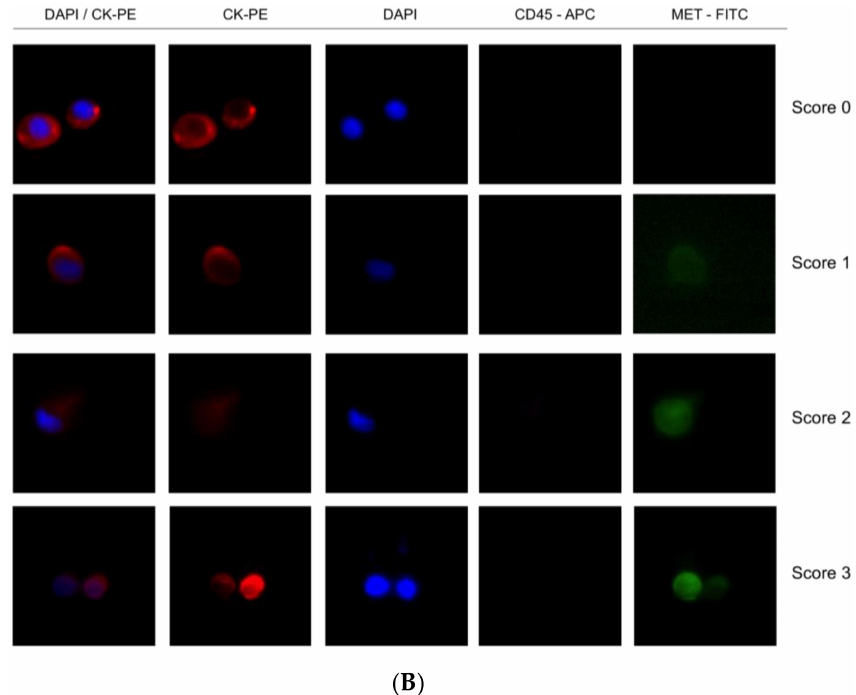
Figure 5. Detection of MET expression using tumor cancer cells with the CellSearch ® and Parsortix systems ( A and B , respectively). Representative images of MET expression scored on score 0 (cell line LNCaP), 1 (cell line AU565), 2 (cell line Hs746T), and 3 (cell line